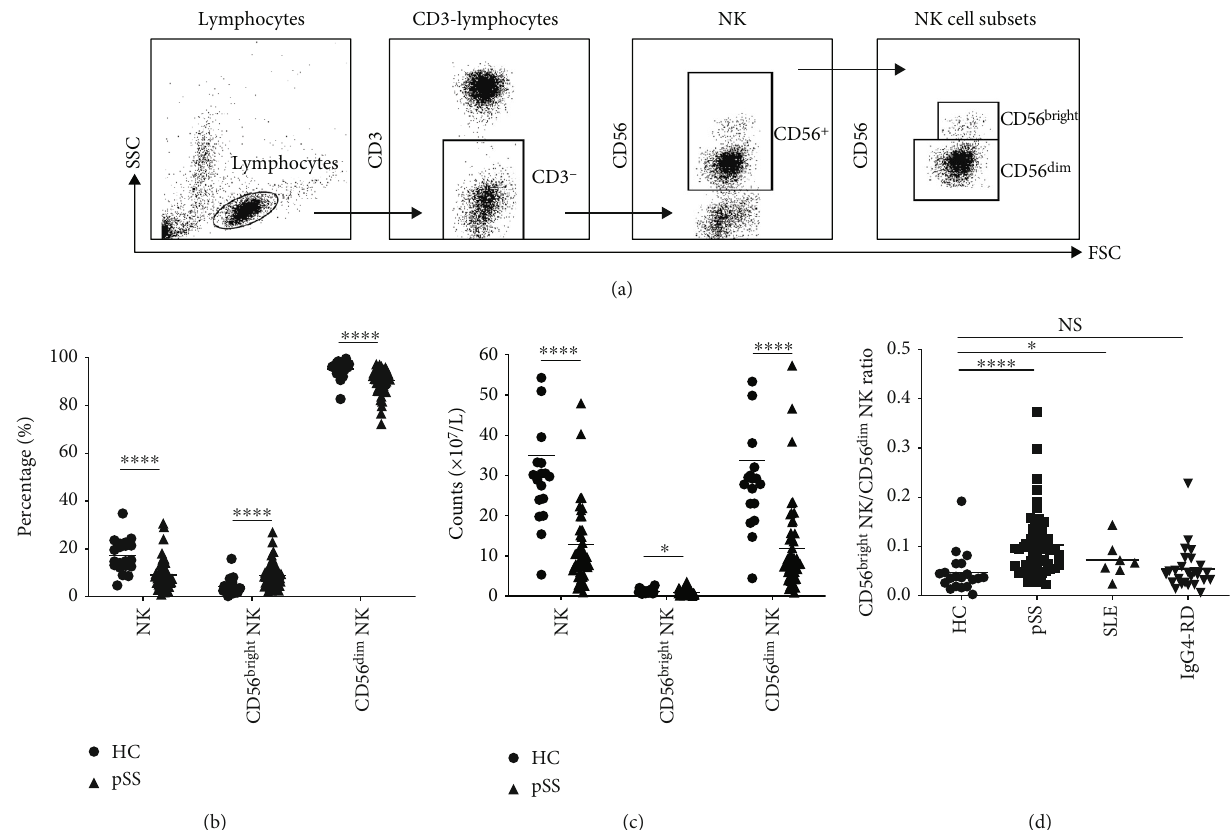
Figure 1: Comparison of percentage and counts of peripheral blood NK cells and CD56 NK cell subsets between pSS patients and HC. (a) The gating strategy is shown for the analysis of NK population. (b) The percentage of peripheral blood NK cells and their constituent CD56 subsets. (c) The absolute number of peripheral blood NK cells and their constituent CD56 NK cell subsets. (d) The ratio of CD56 bright NK/CD56 dim NK in autoimmune diseases. The horizontal line represents the mean. De fi nitions of abbreviations: HC=healthy controls; pSS =primary Sjögren ’ s syndrome.